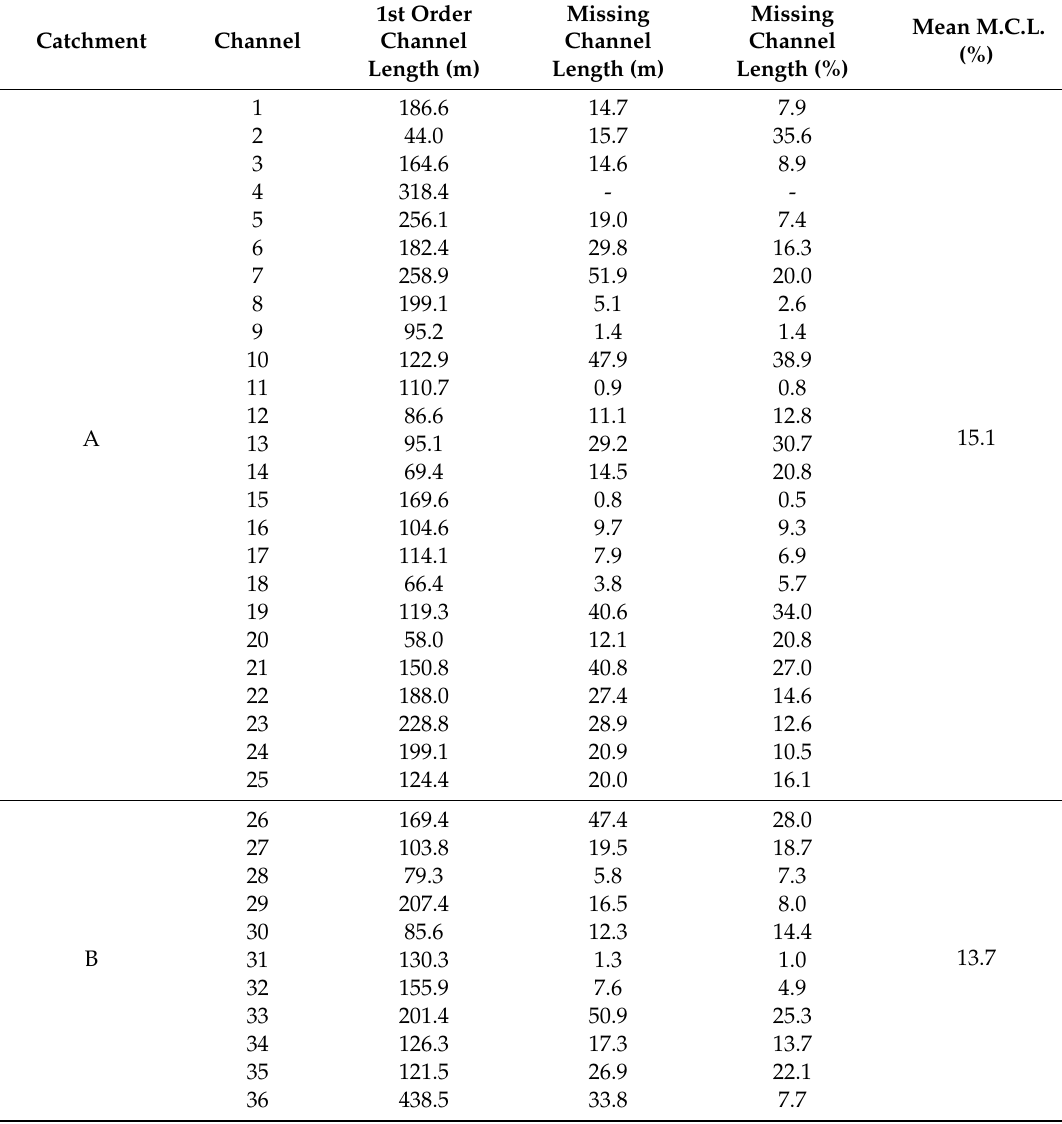
Table 3. Length of the 46 measured first-order channels, in meters. The section of the channels obliterated by agricultural activity is represented as missing channel length, in meters and